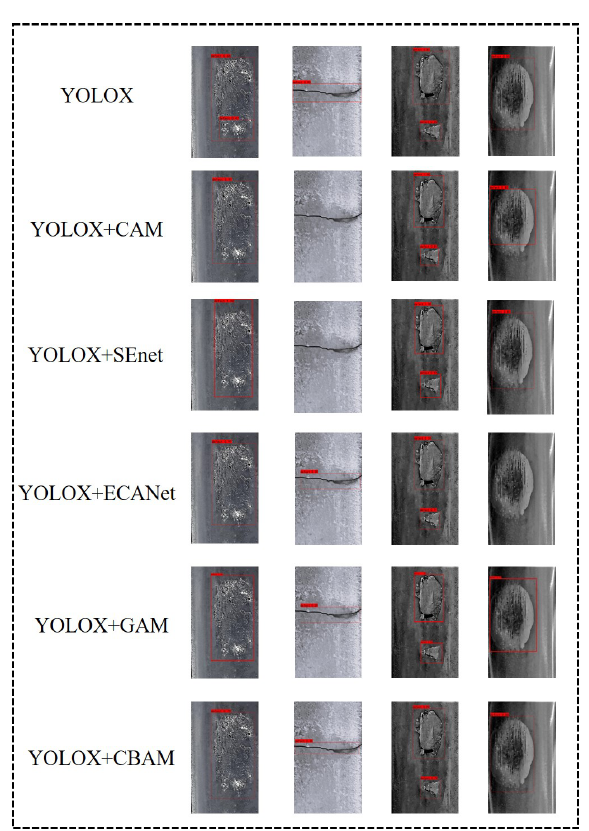
Fig. 10. The detection results of different attention modules in YOLOX.